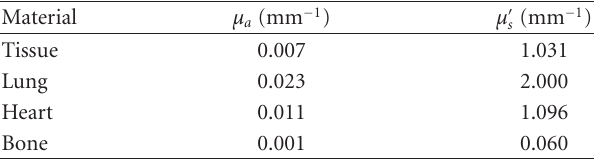
Table 1: Optical parameters of the heterogeneous